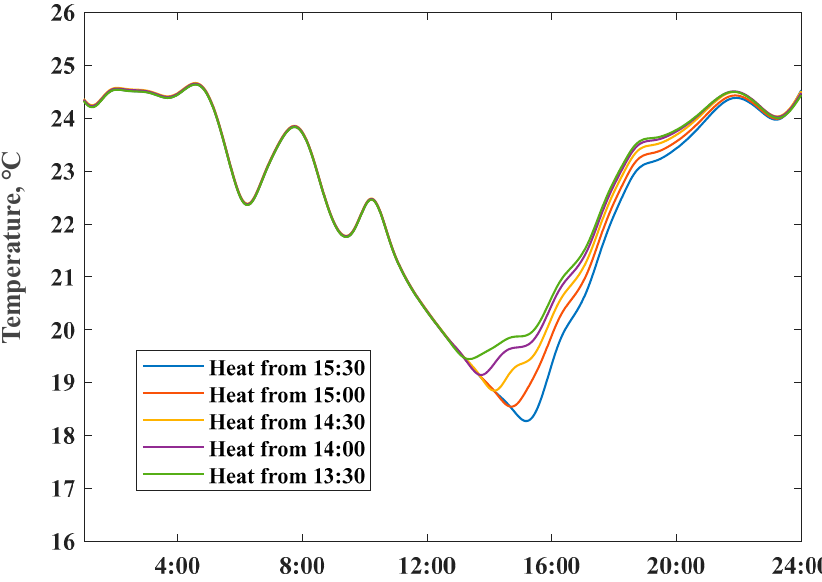
Figure 14. Typical scenario of air conditioner load, PV local consumption, and feed-in power.